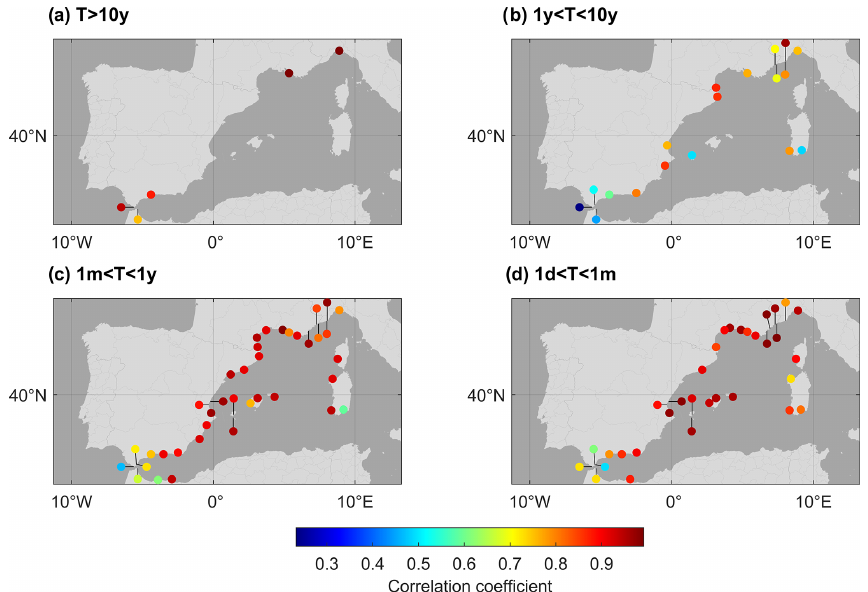
Figure 4. Correlation values between the reconstructed and the original tide gauge series for the four frequency bands: (a) T > 10 y , (b)